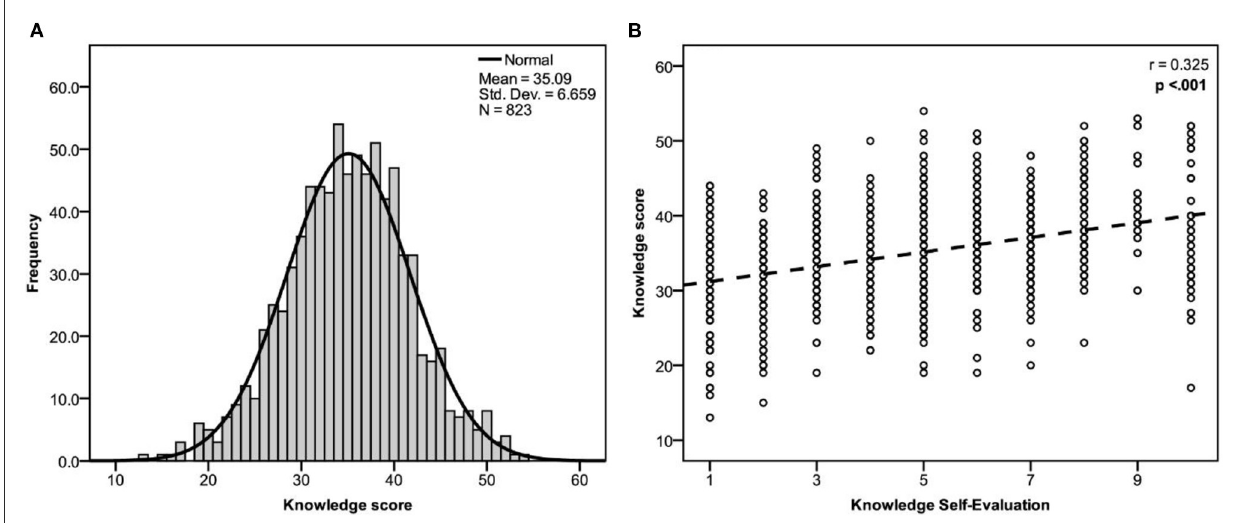
FIGURE1 (A) Knowledge score distribution, (B) Correlation between measured knowledge score and knowledge self-evaluation using spearman’s correlation coefficient (r) and a p -value of 0.05 as a cutoff point for significance.